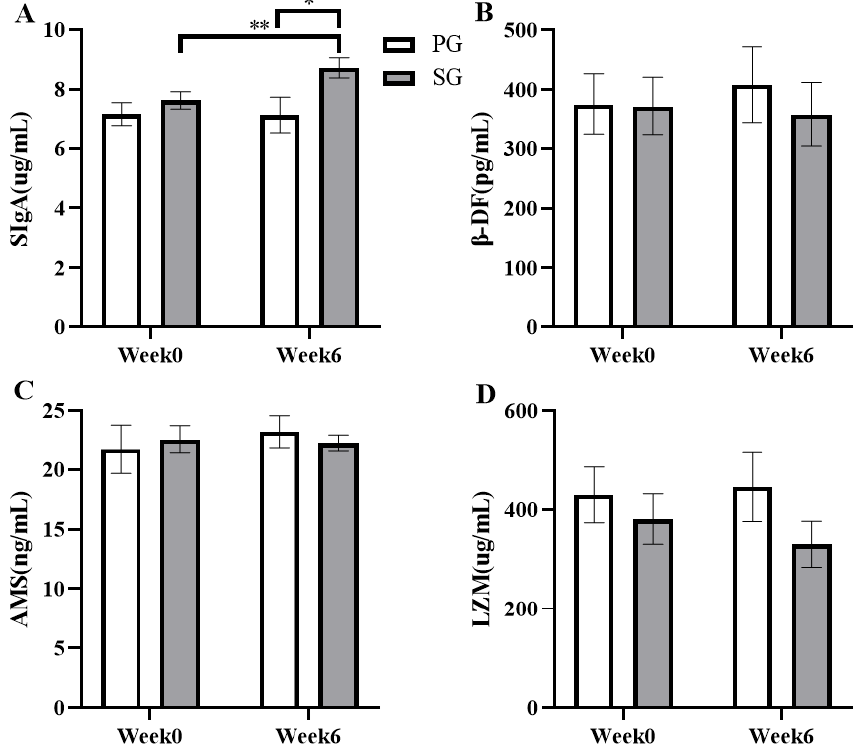
Figure 3. Comparison of the effects of the prebiotic and synbiotic on saliva cytokine concentration at basal status in elite football players. Results are presented as mean ± SEM. PG: prebiotic group (n = 15); SG: synbiotic group (n = 15). ( A ) SIgA concentration. ( B ) β -DF concentration. ( C ) AMS concentration. ( D ) LZM concentration. *: p < 0.05; **: p < 0.01.